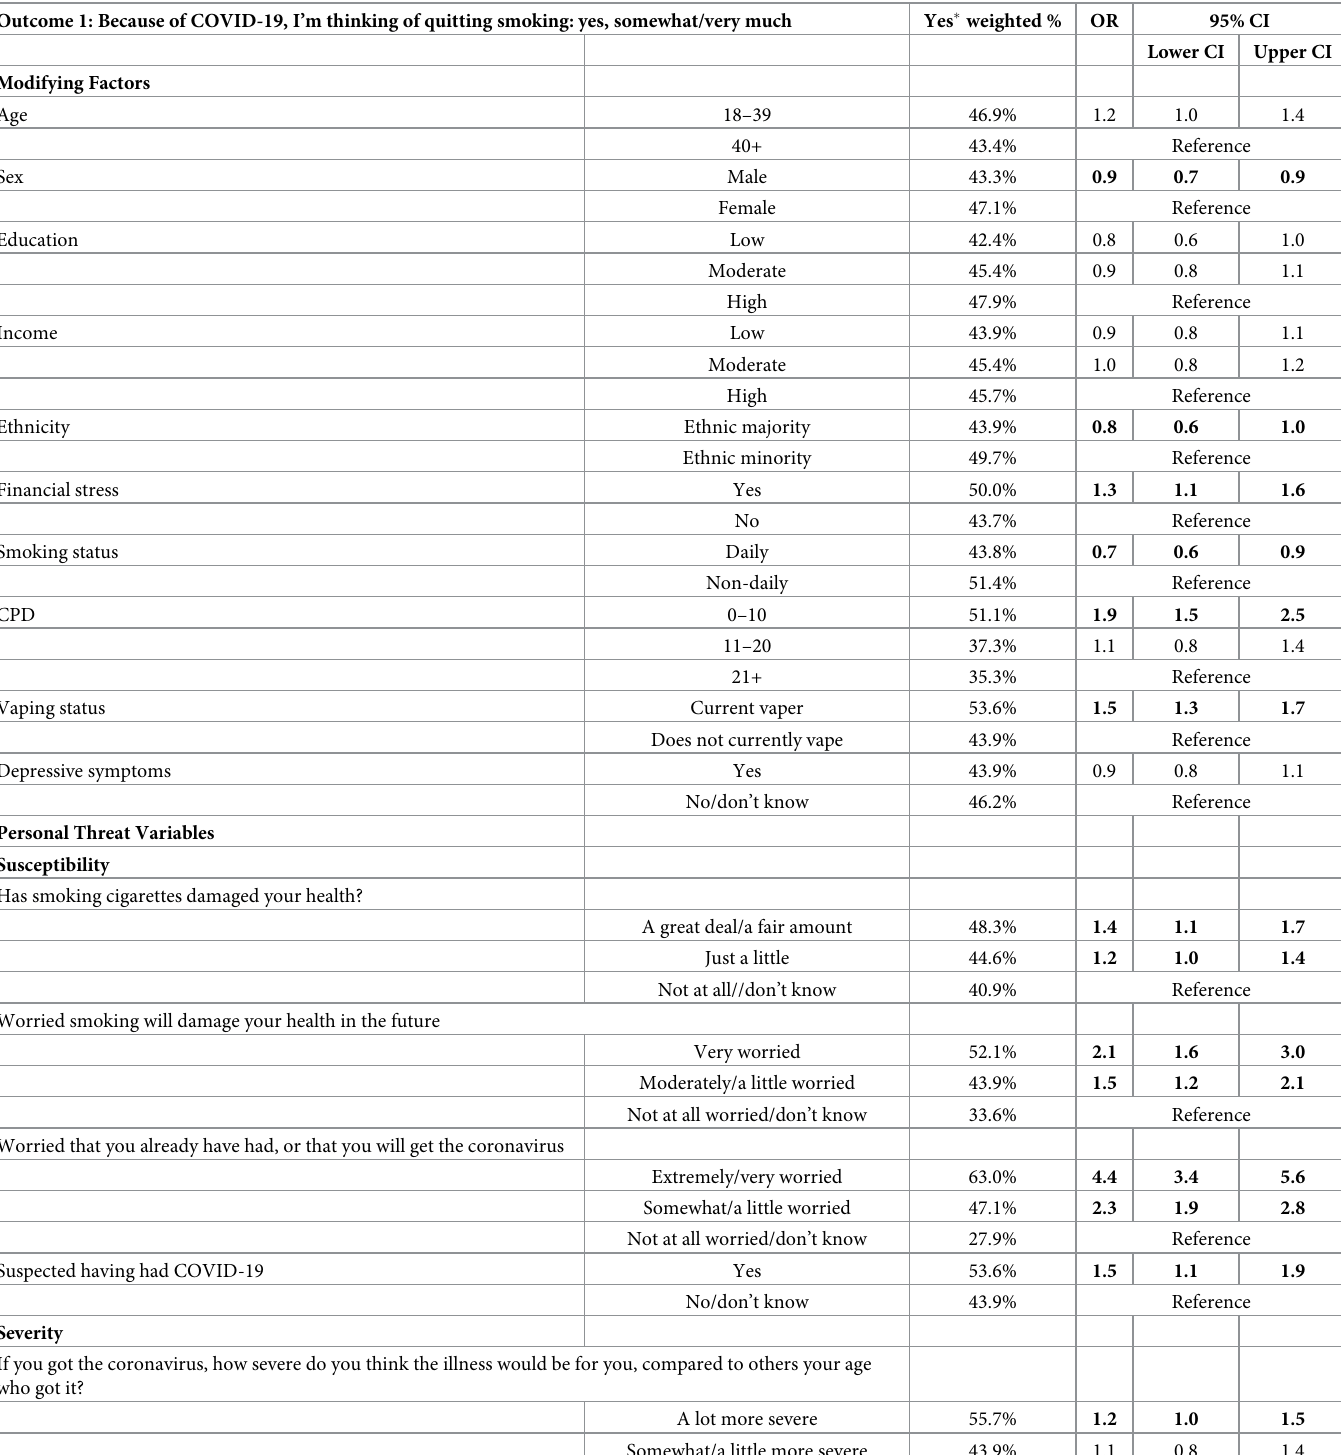
Table 4. Model 1: Regression analyses examining thoughts about quitting smoking because of